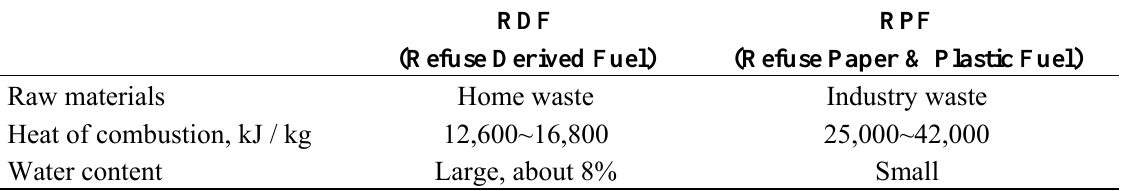
Table 1. Comparison between RDF and RPF